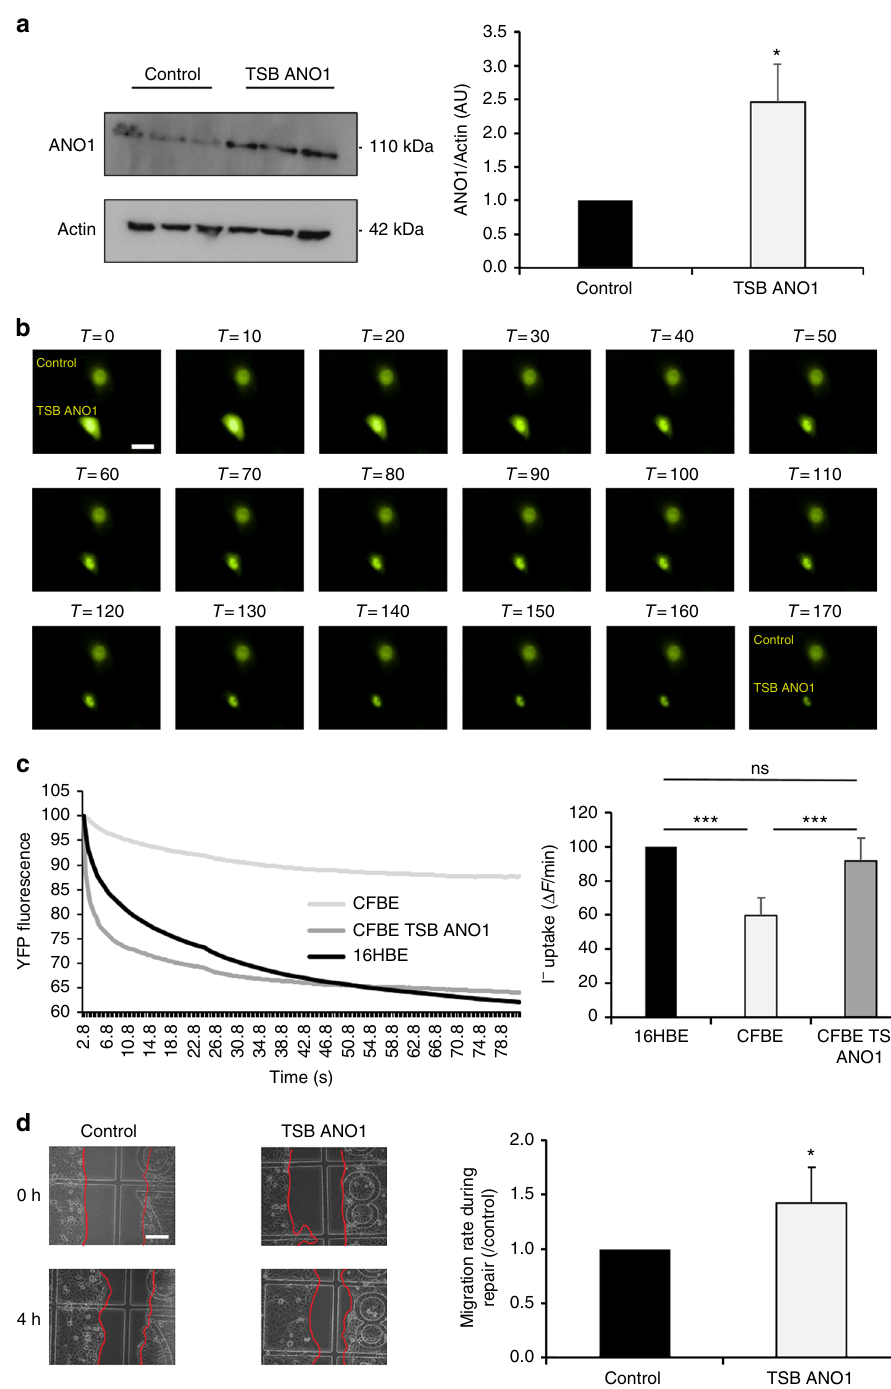
Fig. 4 miR-9-speci fi c TSB increases ANO1 expression, chloride activity, and migration rate. CF cells (CFBE41o-) were transfected with TSB control (control) or ANO1 TSB for 24 h. a ANO1 protein expression was analyzed and quanti fi ed by western blotting using anti-ANO1 antibody. β -actin was used for normalization. ( n = 4, in triplicates). Histograms represent average values ± SDs and were compared using Student ’ s t -test. b Kinetics of YFP-H148Q/I152L protein quenching after addition of I − to the medium. Twenty-four hours after transfection with YFP-H148Q/I152L plasmid, cells were selectively microinjected with TSB control or ANO1 TSB as indicated. Scale bar 5 µ m. c Representative and original traces of ANO1 channel activity ( left ) and quanti fi cation ( right ) of CF bronchial epithelial cells transfected with ANO1 TSB or a negative control ( n = 8, in triplicates) as compared to non-CF cells (16HBE14o-). Histograms represent average values ± SDs and the conditions were compared using ANOVA coupled with Dunnett ’ s, Bonferroni ’ s and Tukey ’ s post hoc test. d Migration rates during repair of CF cells. Representative images were taken during 4 h of wound closure of CF cells ( left ) and migration rates were quanti fi cation ( right ) ( n = 5). Scale bar 10 µ m. Histograms represent average values ± SDs and were compared using Student ’ s t